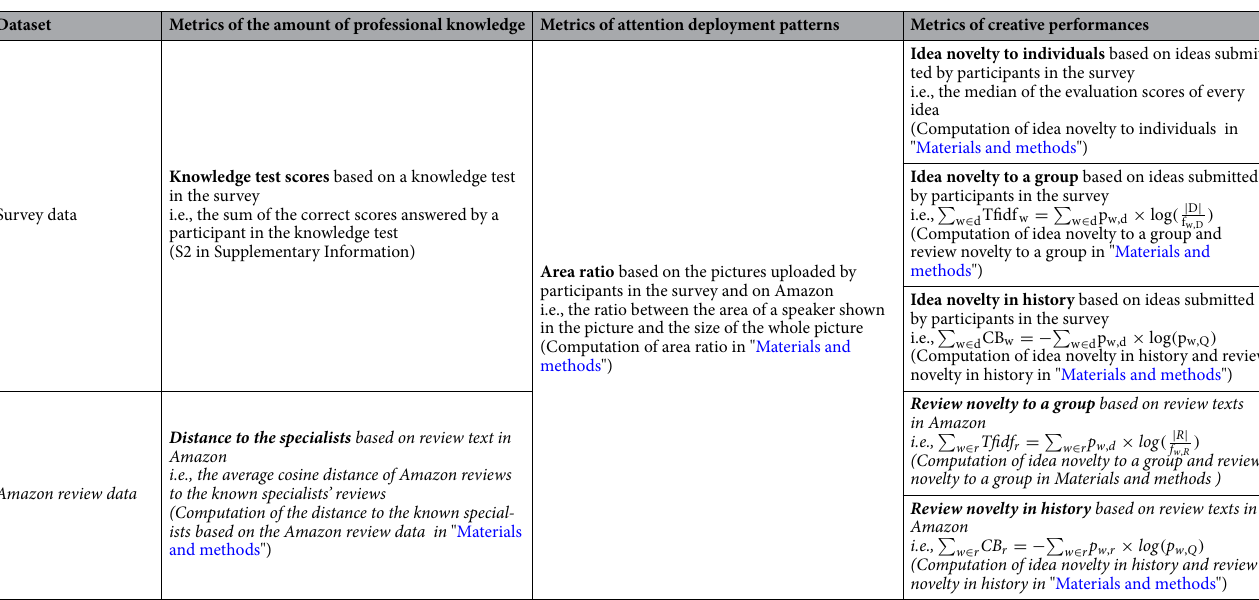
Table 1. Summary of main metrics. In this table, every metric’s name is in bold, followed by the specific data that were used for its construction and a concise explanation of its computation. Parentheses show the sections where the details of the computation were explained. The details of the area in italics are explained in the Supplementary Information.